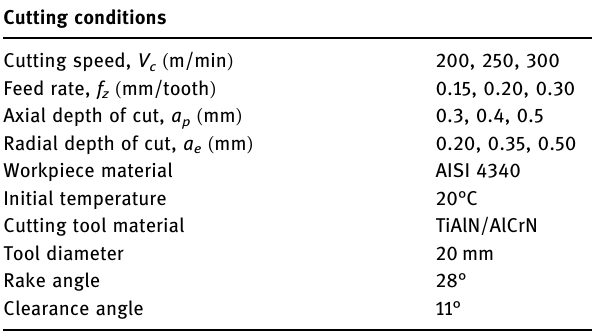
Table 1: Input parameters for FEM